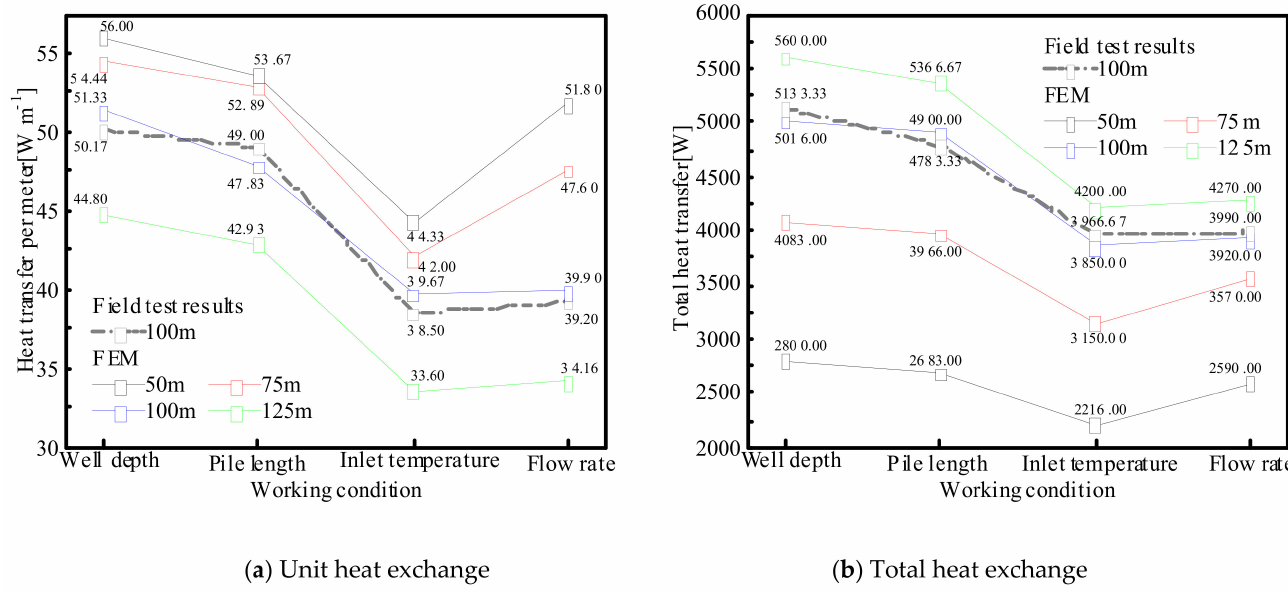
Figure 17. Heat exchange of energy piles under different working